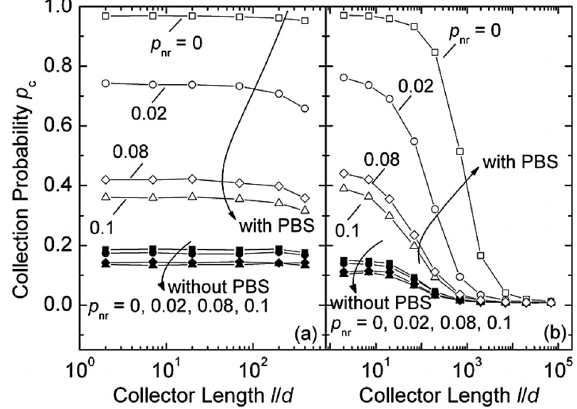
Fig. 8. Comparison of FC systems depicted in Figures 1b and 1c with a constant coverage fraction f = 0 . 01 analyzing influence of non-radiative losses in the dye. (a) Side-mounted system is only modeled up to a collector length l ≤ l max = 4 d/f corresponding to a full coverage of all collector sides. Inclusion of non-radiative losses deteriorates the photon collection p c in all cases. The effect is more significant in the system with ap- plied PBS. (b) Bottom-mounted system. The simulation cov- ers a wider range of collector lengths. With PBS the bottom- mounted system in its radiative limit shows a significant drop in p c for l/d ≥ 100. The inclusion of non-radiative losses re- duces this limit to l/d ≥ 1. In comparison: for p nr = 0 (only radiative losses) the side-mounted system leads to a better pho- ton collection p c , especially at large values of l . Inclusion of non-radiative losses leads to the same behavior in the largescale region, but for collector lengths in the statistical limit, the bottom-mounted system performs better. Without PBS the side-mounted system yields higher p c at all collector lengths even with inclusion of non-radiative